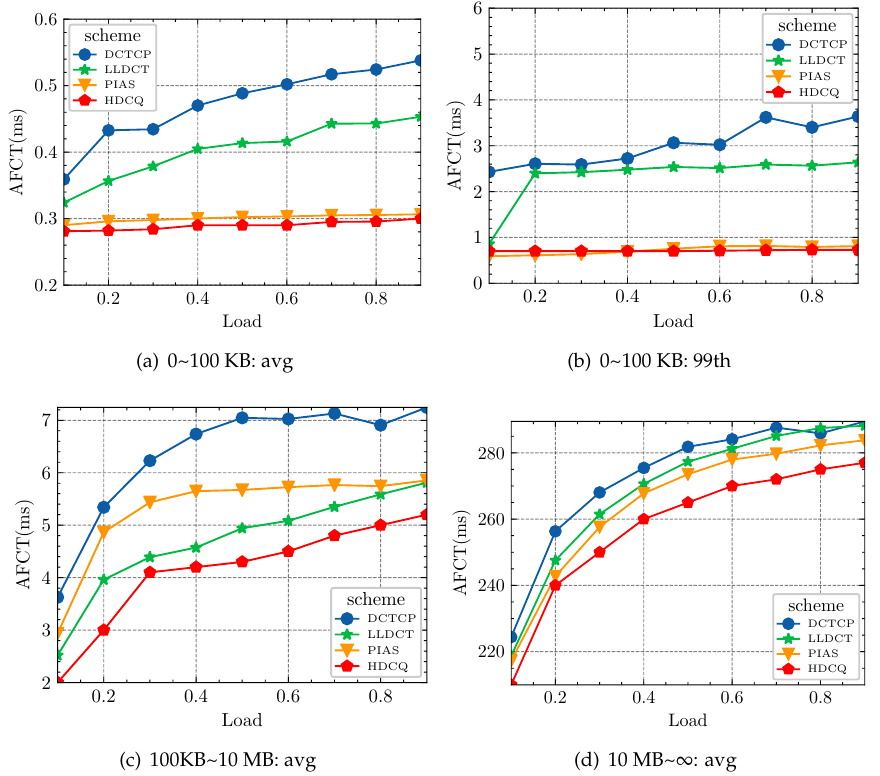
Figure 11. Data mining workload: FCT across different flow